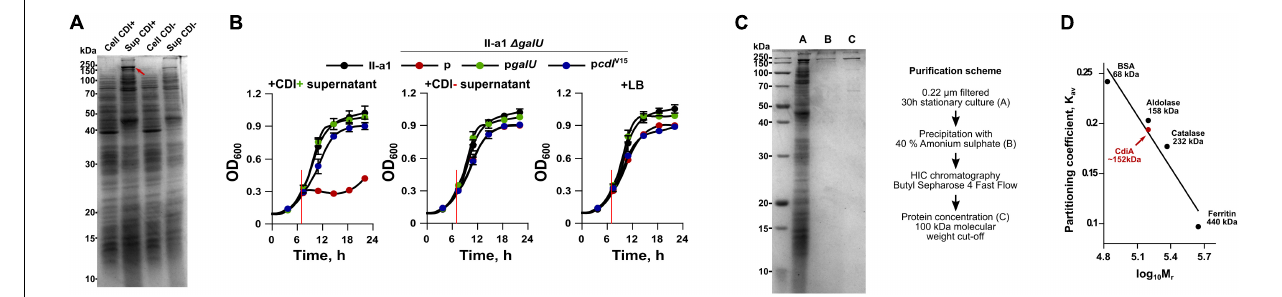
FIGURE 4 | (A) An SDS-PAGE analysis of total protein fraction from cell extract (Cell) and culture media (Sup) of both A. baumannii V15 (cid:49) bfmRS (CDI + ) and (cid:49) bfmRS (cid:49) cdi V15 (CDI - ) strains. Proteins from culture media were precipitated with trichloroacetic acid (TCA). Samples were run on a 12.5% SDS-PAGE gel. Approximately 5 µ g of the total protein were loaded into each well. The red arrow denotes CdiA protein band. (B) Growth inhibition assays of II-a1 strain, its galU mutant, and galU mutant complemented with either wild-type galU gene or immunity gene cdiI V15 from the A. baumannii V15 strain. Red vertical lines denote the time when 10 µ l of 0.22 µ m filtered culture media from (cid:49) bfmRS (CDI + ), (cid:49) bfmRS (cid:49) cdi V15 (CDI - ), or LB, were added. Error bars represent standard deviation. Values were calculated from three independent experiments with two technical replicates each. (C) 12.5% SDS-PAGE gel showing purity of CdiA after each purification step. The scheme of CdiA purification is denoted on the right. Approximately 10 µ g of the total protein were loaded into the well with TCA-precipitated total protein fraction from culture media, and 1 µ g of the total protein for all other wells. (D) Calibration curve used to determine the molecular weight of CdiA by size-exclusion chromatography. Black dots with names and their sizes (in kDa) denote proteins used for molecular mass standard curve. Red dot denotes calculated CdiA molecular mass. K av denotes molecule partition coefficient, calculated as ( V e – V o )/( V t – V o ), where V e – elution of the molecule (mL), V o – column void volume (mL), and V t – total column volume (24 mL). Log 10 M r denotes decadic logarithm of the molecular weight. For SDS-PAGE analyses, PageRuler TM Unstained Broad Range Protein Ladder (Thermo Fisher) was used as a marker. Numbers on the left of the gels denote molecular mass in kDa. Bands in gels were stained with Coomassie Brilliant